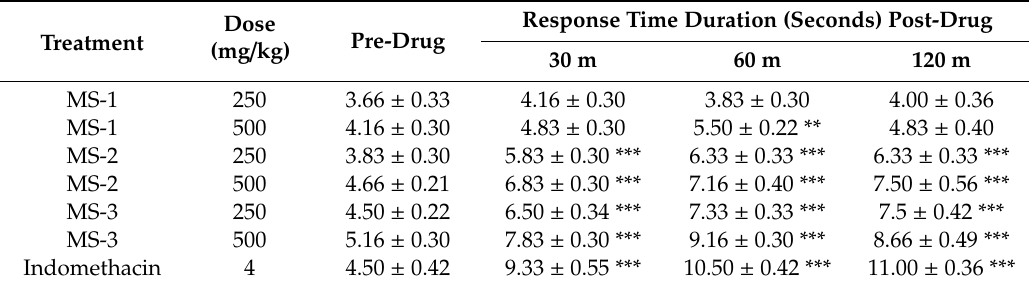
Table 4. Analgesic e ff ects of M. sinaica fractions on the tail flick method in mice. Treatment